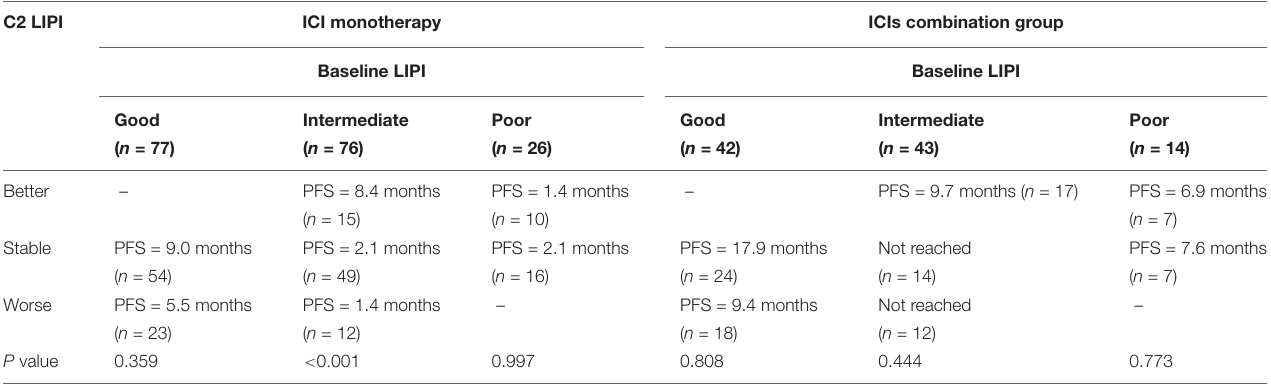
TABLE 4 | The relationship between dynamic LIPI and PFS, and stratified LIPI before the second cycle of treatment (C2 LIPI). C2 LIPI ICI monotherapy ICIs combination group Baseline LIPI Baseline